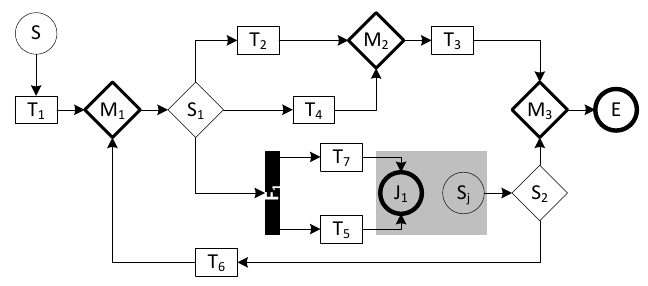
Figure 12. Entry graph of a join node J